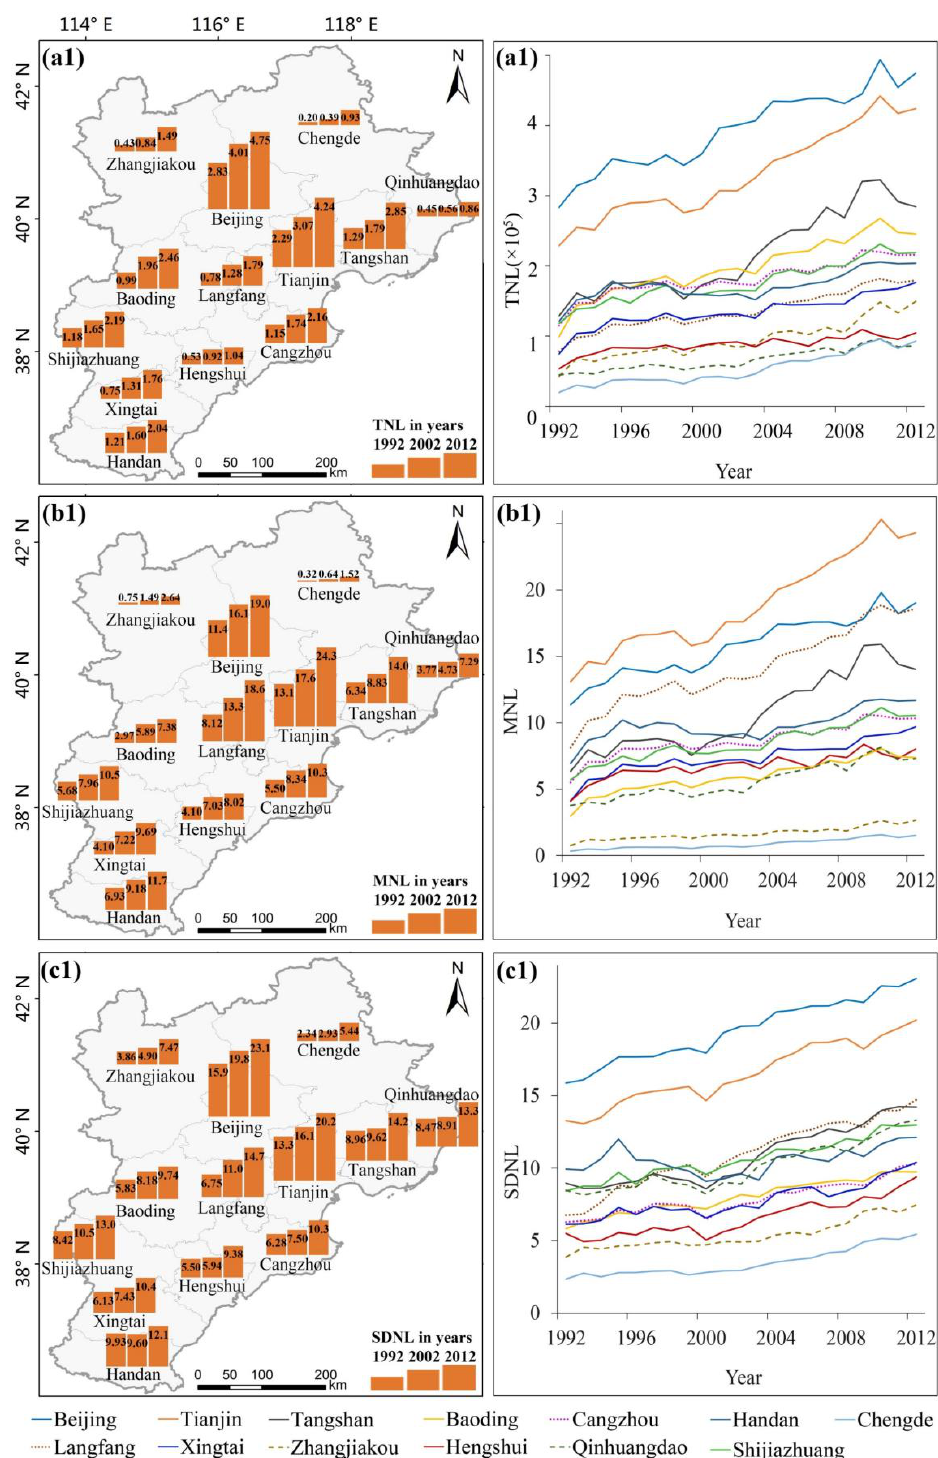
Figure 5. ( a1 , a2 ) TNL and its change trend of cities at the prefecture level in the Beijing-Tianjin-Hebei region; ( b1 , b2 ) MNL and its change trend of cities at the prefecture level in the Beijing-Tianjin-Hebei region; ( c1 , c2 ) SDNL and its change trend of cities at the prefecture level in the Beijing-Tianjin-Hebei region.